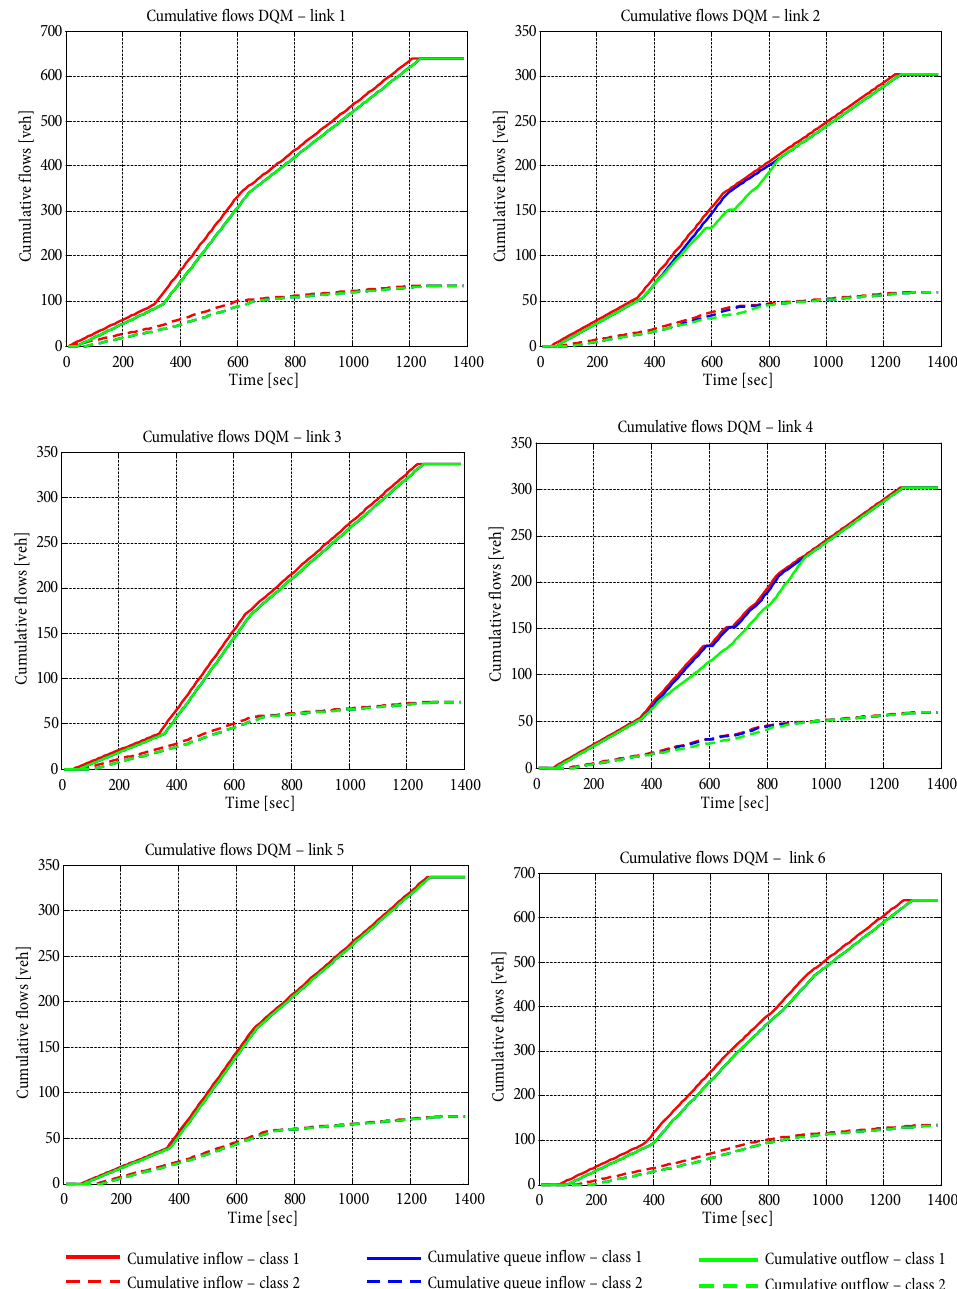
Fig. 9. Cumulative flows for multi-class